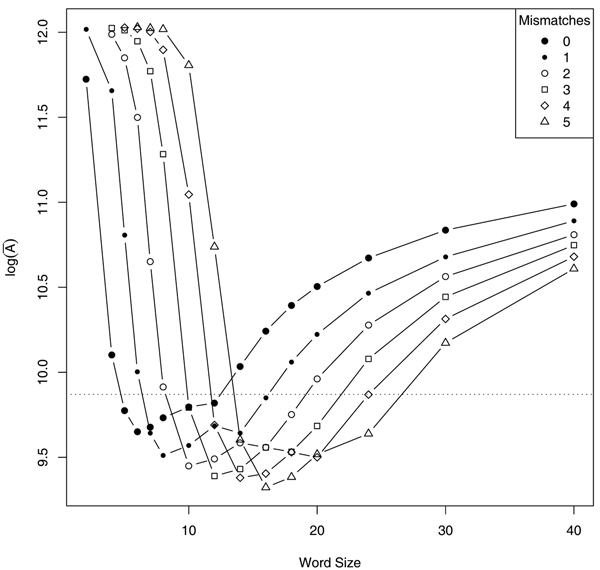
Effect of the number of mismatches on the accuracy of . The curves show the accuracy of the  statistics according to the word length and for various mismatches per word. In this simulation, sequence sizes of 600 letters were used. The dotted line shows the results obtained with BLAST.